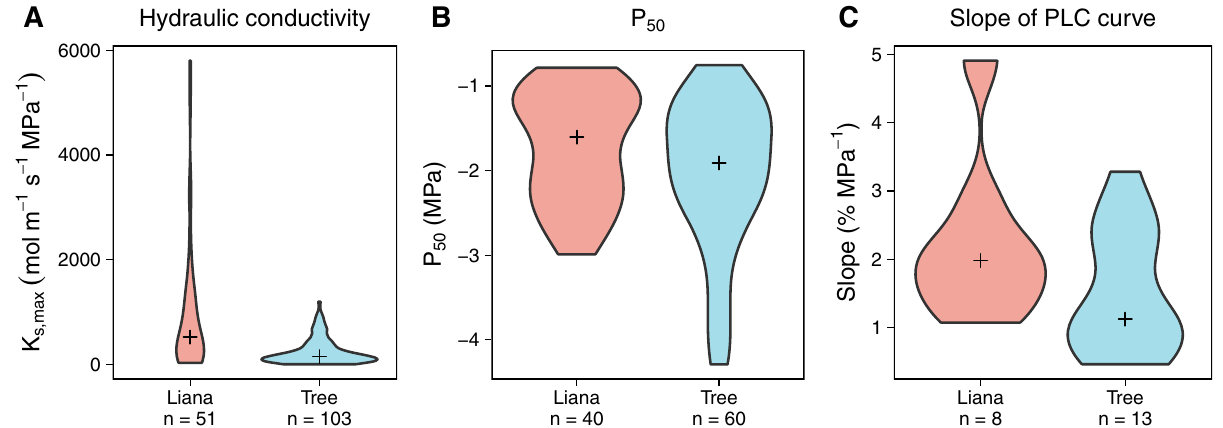
Fig. 1 Hydraulic trait differences between growth forms. A Lianas have substantially greater stem-speci fi c hydraulic conductivity (K s,max ) and B marginally less negative pressure at which 50% xylem function is lost (P 50 ). C Slope of the percent loss of conductivity (PLC) curve does not differ between growth forms. Results derived from our extended meta-analysis, which combines observations from the TRY database with more recent hydraulic trait measurements. Red violins represent lianas, blue violins represent trees. Black crosses represent medians for each growth form. Number of species for which each trait was measured is indicated below the growth form